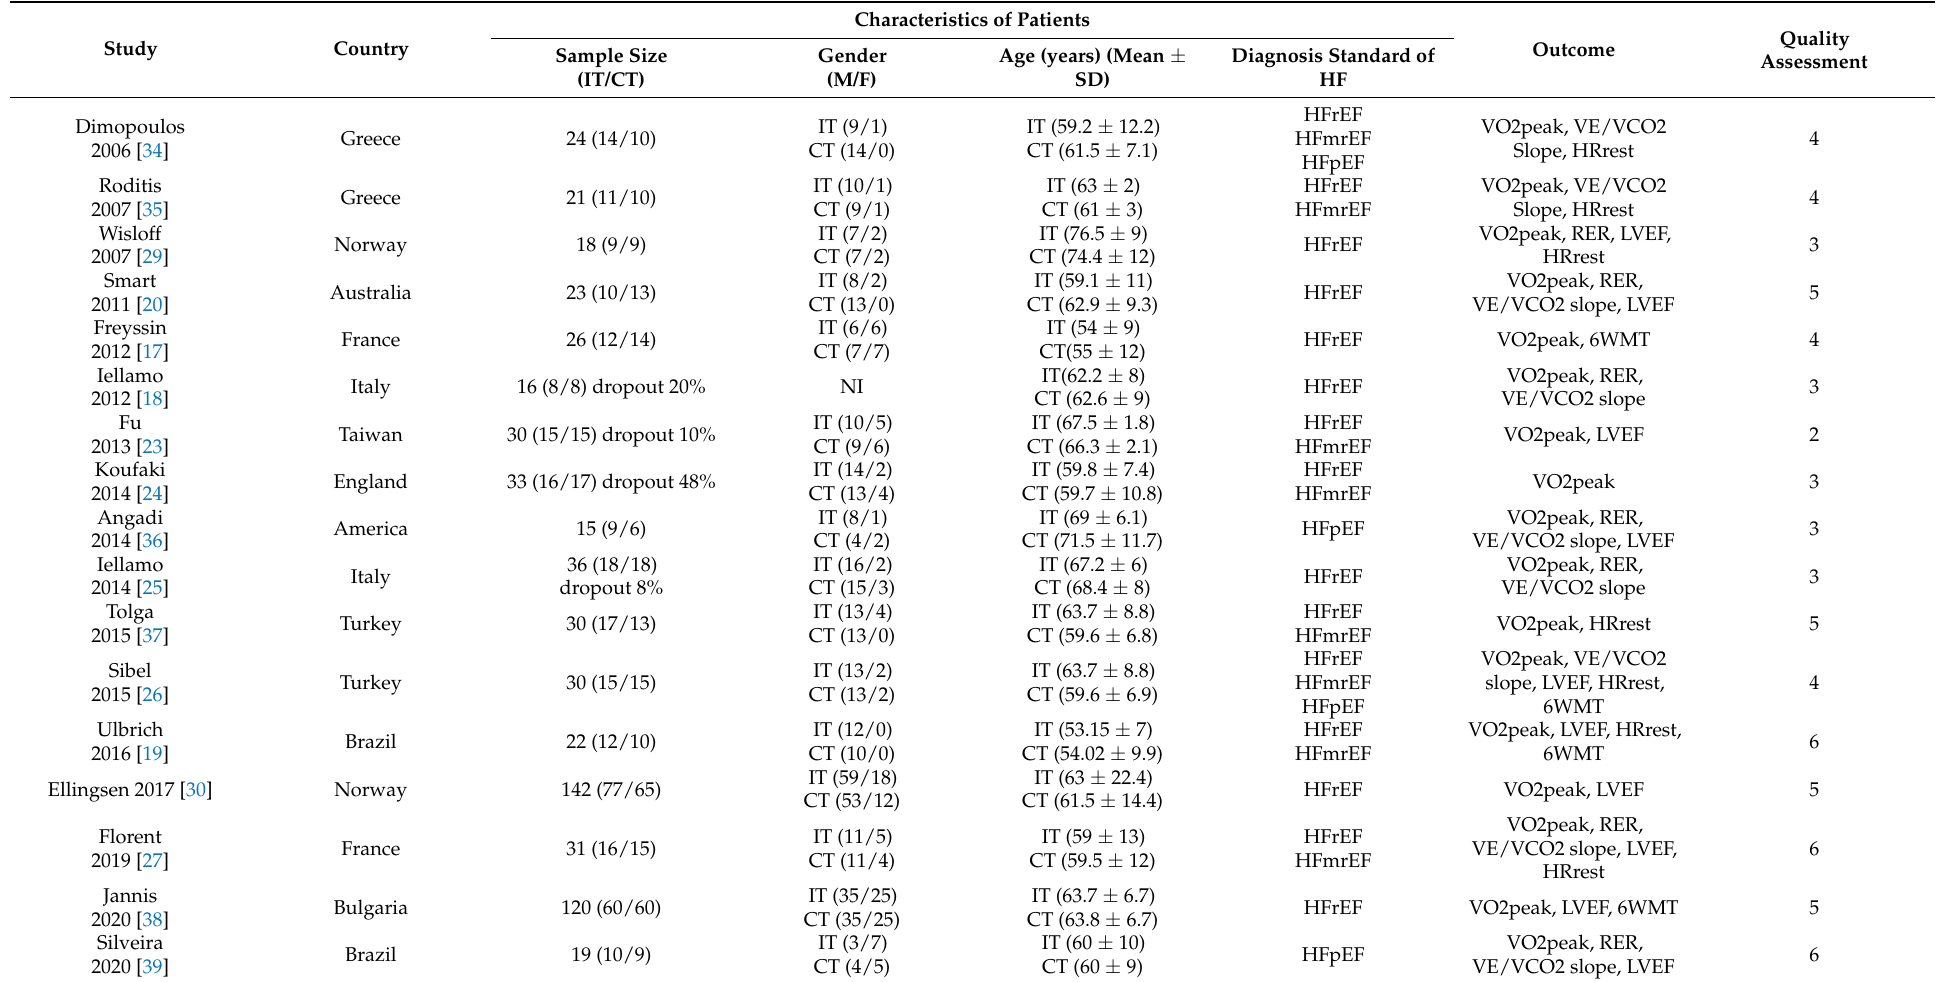
Table 1. Characteristics of the studies included in the